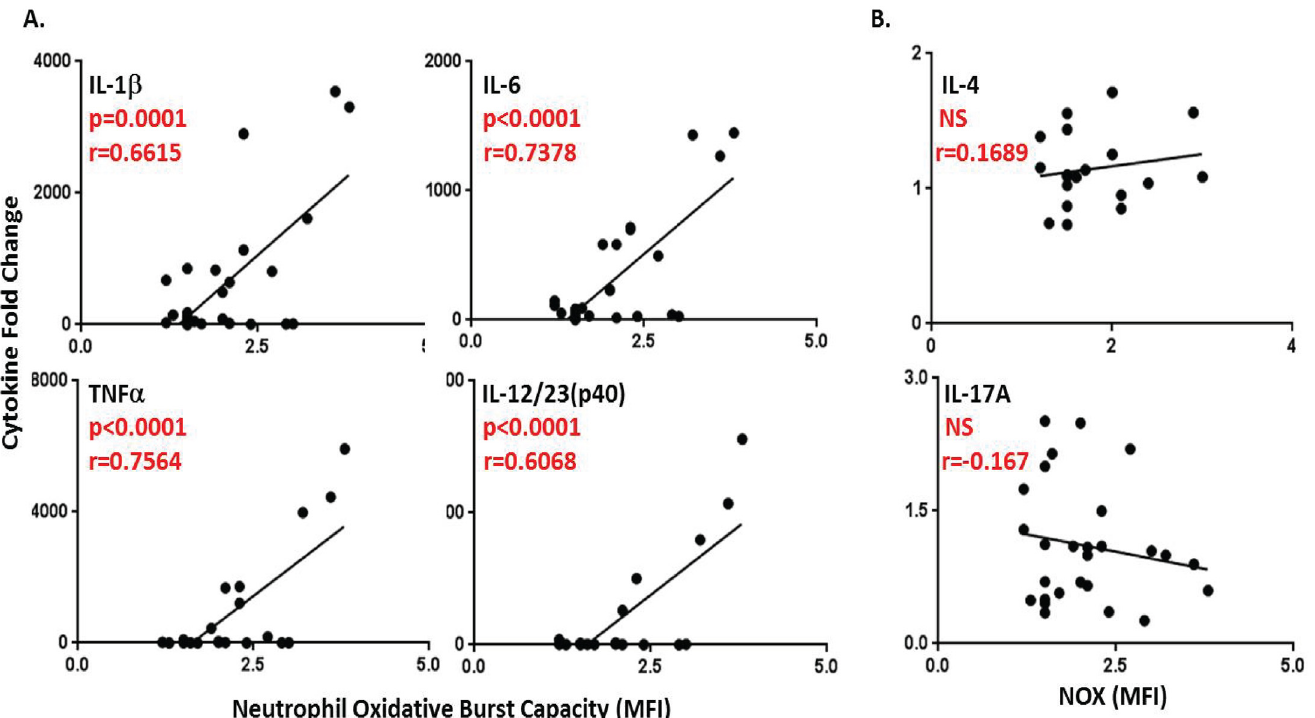
Fig 3. Baseline neutrophil oxidative burst capacity is predictive of ex-vivo whole blood production of IL-1 β , IL-6, TNF α , and the Th1-polarizing cytokine, IL-12/23(p40). (A) Scatter plots of cytokine fold change (y-axis) and neutrophil oxidative burst fold change in MFI (x-axis) that were determined to have statistically significant correlative coefficient (r) values (p (cid:1) 0.0001) by Pearson ’ s Test. (B) Scatter plots of cytokine fold change and neutrophil oxidative burst capacity fold change for two cytokines found to be not statistically significant: IL-4 (Th2 cytokine), IL-17 (Th17 cytokine).